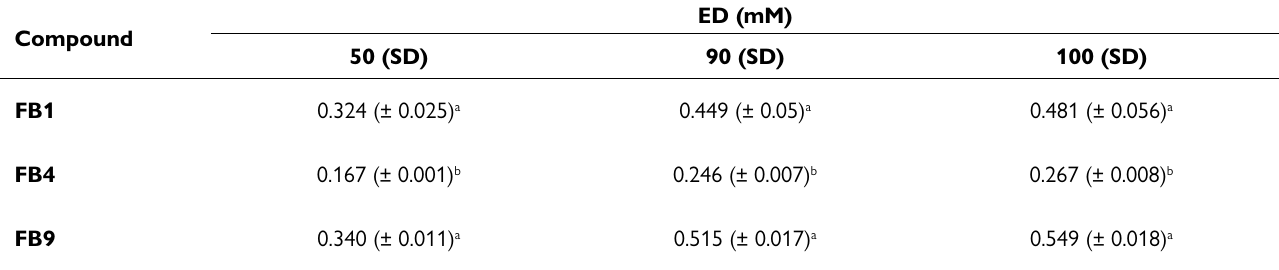
, ED , and ED determined for the eugenol derivatives against adult worms of S. mansoni after 192 hours of contact with FB1, FB4, and FB9. Table 1. ED 50 90 100